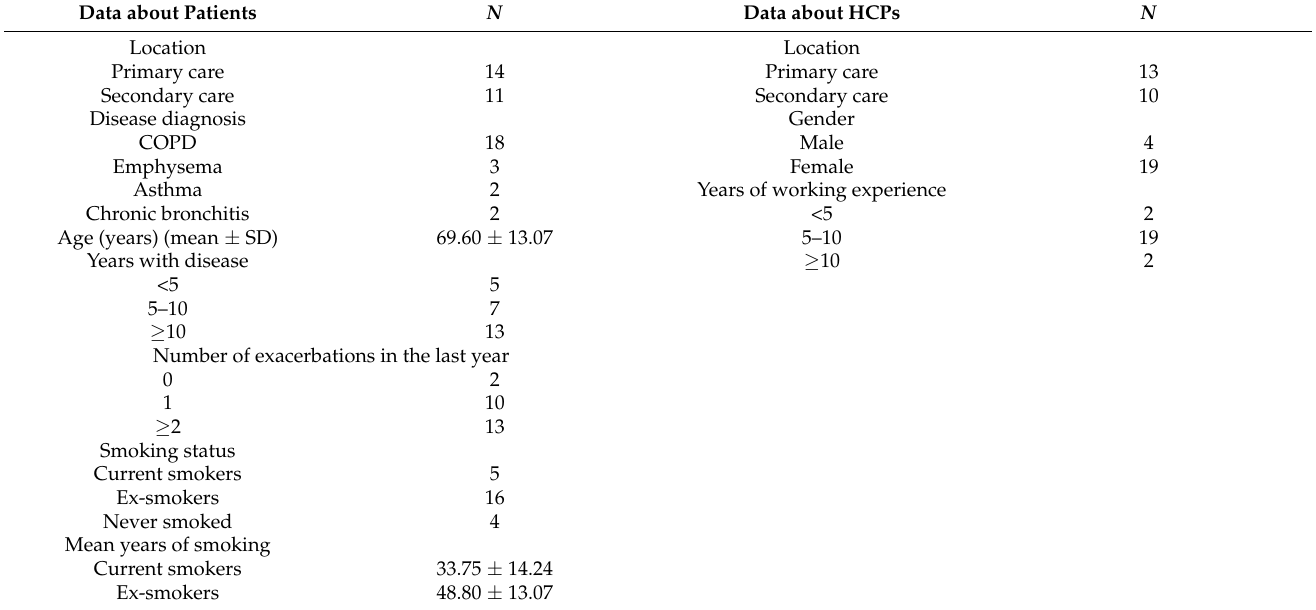
Table 2. Descriptive statistics of patients and healthcare professionals